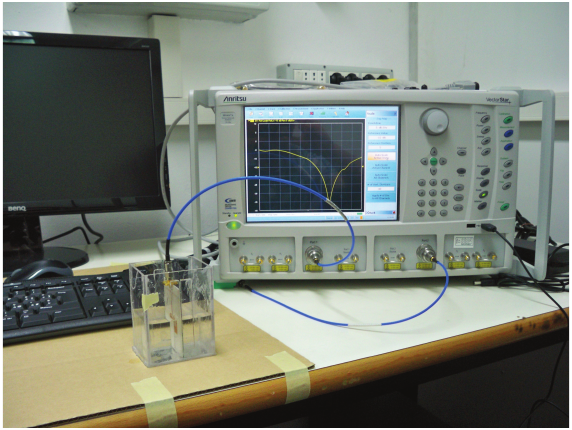
Figure 6. Measurement setup into ERMIAS Lab at University of Calabria [10].